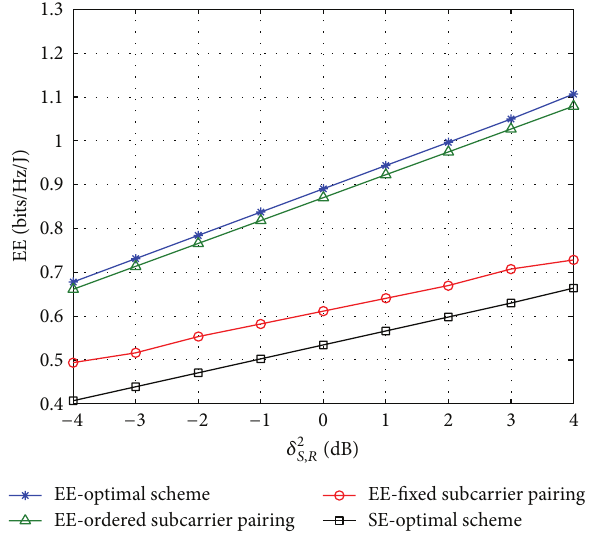
Figure 2: Energy efficiency versus channel variance of 𝑆 → 𝑅 link with 𝑁 = 2 relays, and 𝑤 1 = 𝑤 2 = 1 .